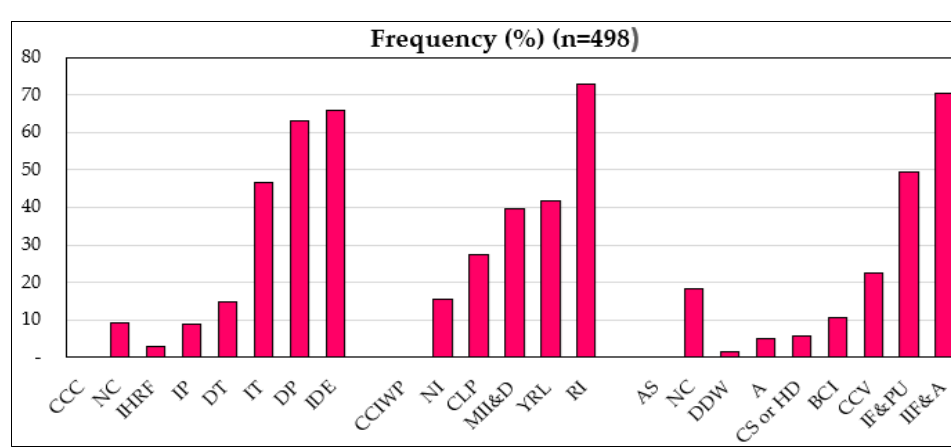
Figure 3. Percentage of farmers’ perceptions of CC and its influence on maize productivity and farmers’ adaptation practices. Note: Climate change cognition (CCC) = No change (NC), Increased heavy rainfall (flood) (IHRF), Increased precipitation (IP), Decreased temperature (DT), Increased temperature (IT), Decreased precipitation (DP), Increased drought event (IDE). Climate change impact on maize production (CCIMP) = No influence (NI), Crop loss due to precocity (CLP), More infestation of insects and diseases (MII&D), Yield reduction due to lodging (YRL), Require more irrigation (RI). Adaptation strategies (AS) = No change (NC), Drill the deep well (DDW), Afforestation (A), Change seeding or harvesting date (CS or HD), Buy climate insurance (BCI), Change crop varieties (drought tolerant and disease) (CCV), Boost fertilizer and pesticides usage (BF&PU), Rise irrigation frequency and amount (IIF&A).